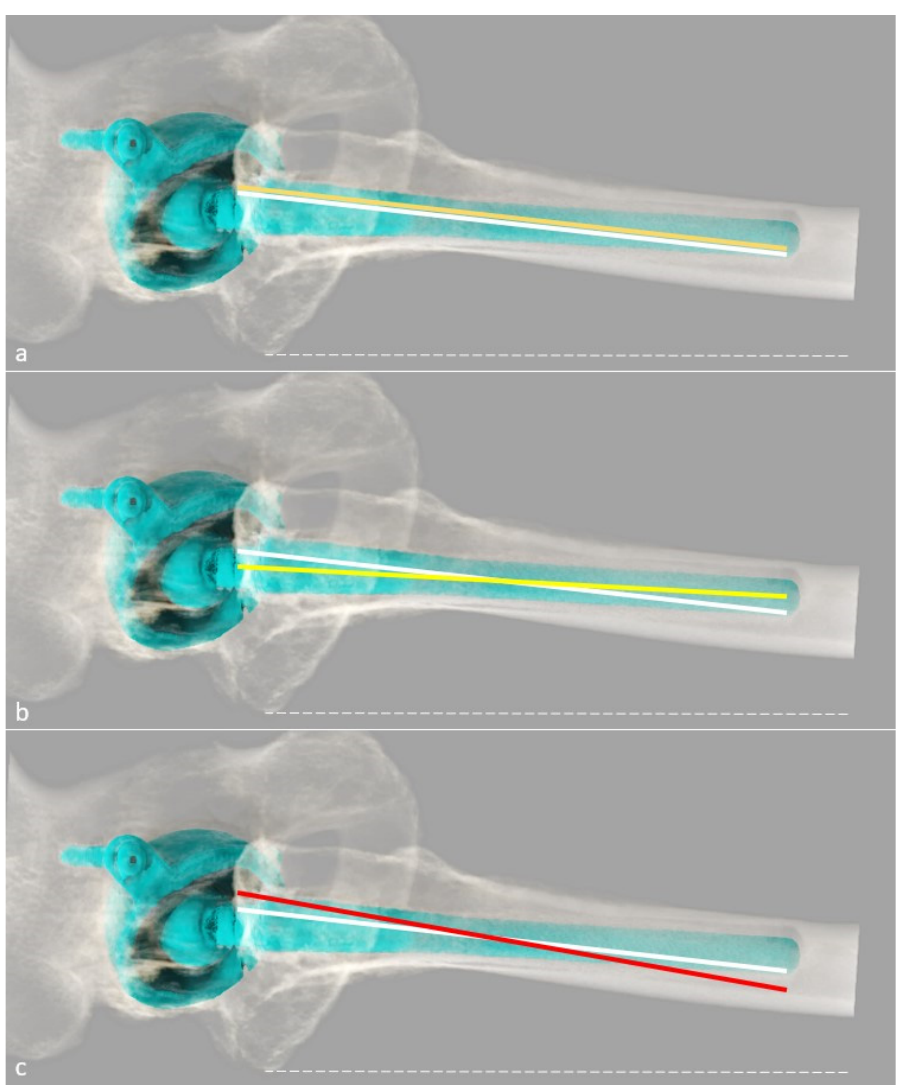
Figure 3. Representation of the flexion/extension of the femoral stem, using 3D CT ‐ scan reformat, adapted from Abe et al. [23]. The dotted white line represents the retrocondylar axis, the white line the sagittal femoral tilt, and the colored line the stem axis. A theoretical neutral position is shown in ( a ) with the orange line; a negative value superior to − 3° between the femoral tilt and the sagittal stem tilt is defined as flexion in ( b ) with the yellow line, which is the actual axis of this prosthesis; and a positive value superior to 3° is defined as an extension in ( c ) with the red line.